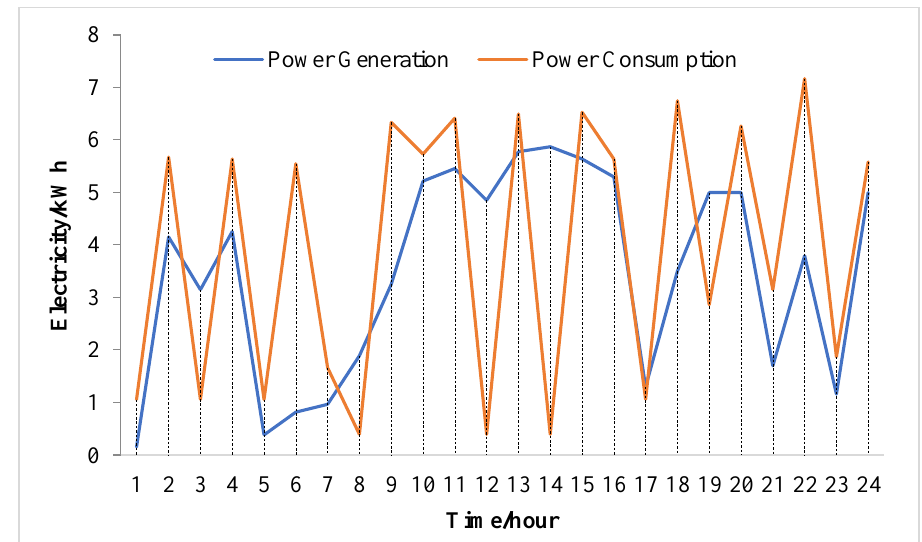
Figure 4. The change in power generation and electricity consumption before VES.